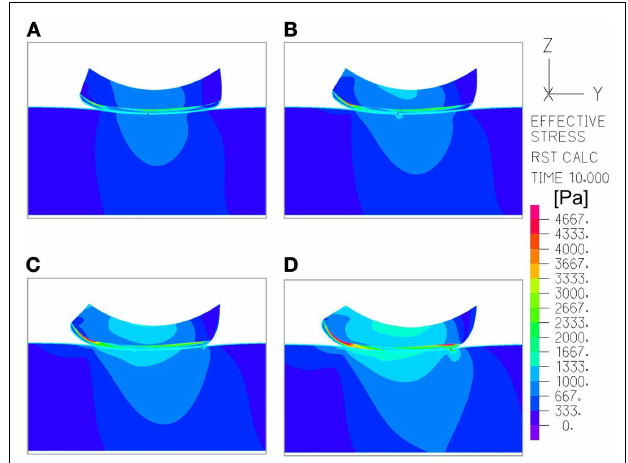
FIGURE 5 |An example of the distribution of effective stresses in the region of interest, at the end-point of the repositioning process in the simulations ( t = 10s), which depicts how the moisture-related skin-support coefficient of friction (COF) influences internal skin and subcutaneous stresses .The skin and subcutaneous stress data were always collected from the latest time-step of the simulations, that is, at the end-point of the displacement regime, since tissue loads were maximal at that time point. In this example, the skin stiffness was 100kPa and the COF varied as followed: (A) 0.2; (B) 0.4; (C) 0.6; (D) 0.8.The value range in the color bar was set to be from zero to a maximum of